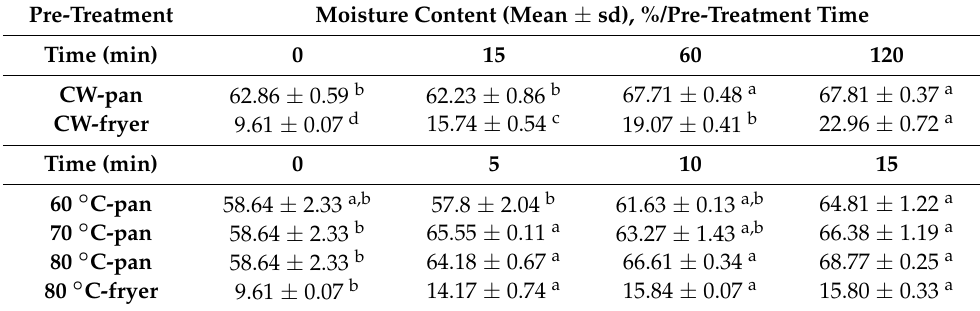
Table 1. Moisture content of French fries pre-treated with water.